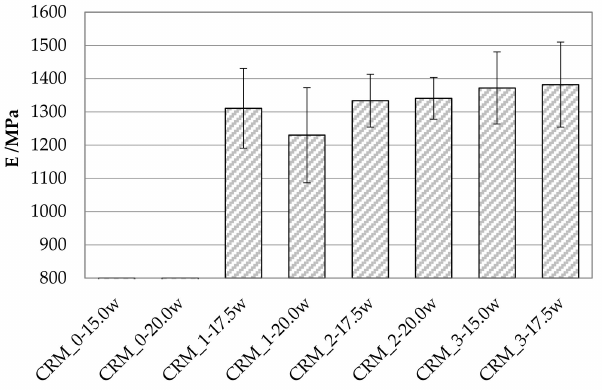
Figure 7. Stiffness moduli of investigated